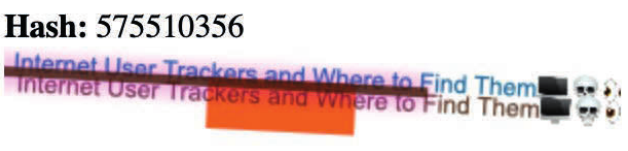
Fig. 1. The web page that initially contains two tags to display a label and a calculated hash value. The calculation invokes a creation of a canvas element that is later converted to a Base64 encoding and